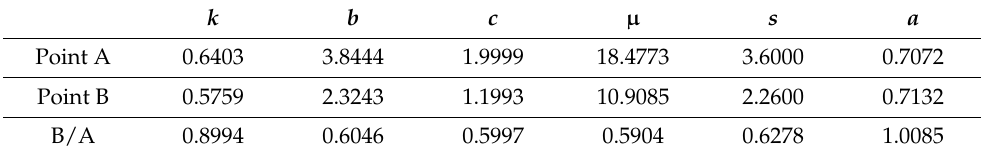
Table 3. The values characterizing the density distributions for points A and B.